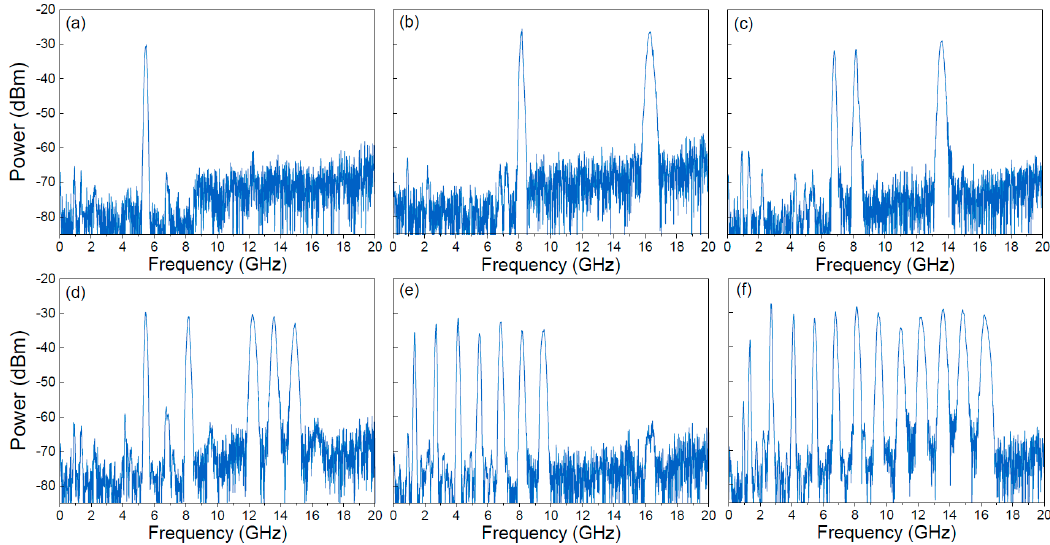
Figure 8. Measured frequency spectra of the reconfigurable microwave photonic multiband filter with different passband combinations [33]. ( a ) One single passband at 5.4 GHz. ( b ) Two passbands at 8.1 GHz and 16.2 GHz. ( c ) Three passbands at 6.7 GHz, 8.1 GHz and 13.6 GHz. ( d ) Five passbands at 5.4 GHz, 8.1 GHz, 12.2 GHz, 13.6 GHz, and 14.9 GHz. ( e ) Seven passbands from 1.3 GHz to 9.5 GHz. ( f ) Twelve passbands from 1.3 GHz to 16.2 GHz (All twelve passbands shown in Figure 7a).